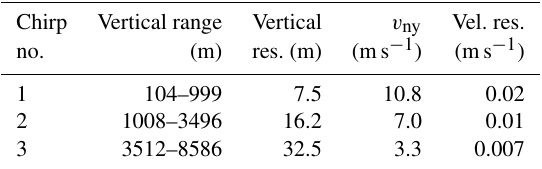
Table 1. Parameters of the measurement setup of WProf. Each ver- tical profile is divided into three regions, denoted by a chirp number, listed in the first column of this table. The second and third column provide the vertical range and the range resolution for each of the chirps. The Nyquist velocity ( v ny ) and velocity resolution of the Doppler spectra collected in each region of the profiles are listed in the fourth and fifth